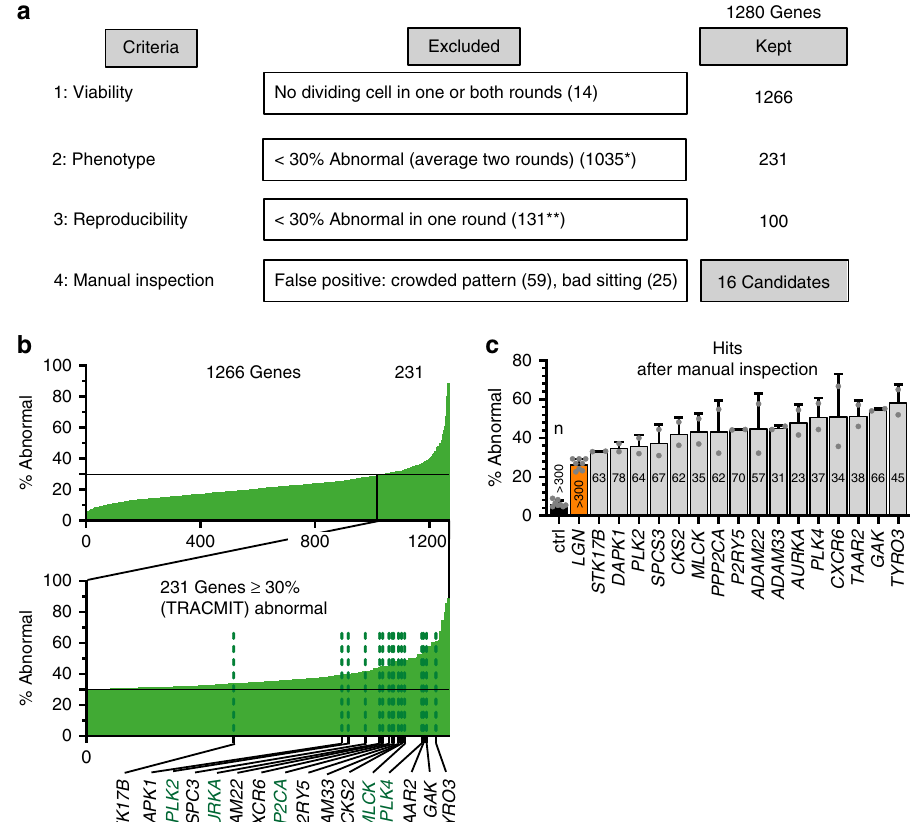
Fig. 2 Identi fi cation of 16 spindle positioning candidate genes. a Schematic representation of step-wise hit selection procedure following two rounds of screening a small interfering RNA (siRNA) collection targeting 1280 kinases, phosphatases, metalloproteases, G protein-coupled receptors and associated proteins. Left column: four criteria that were evaluated successively; middle column: exclusion criteria and number of excluded genes at each step; right column: number of genes kept after each step. *Including one gene with ≤ 10 cells to analyze and one gene with only two cells to analyze in one round, and a manually con fi rmed phenotype in the other round (PPP1CB). **Including eight genes with ≤ 10 cells to analyze and two genes with >10 cells in one round, and a manually con fi rmed phenotype in the other round, but with <20 cells to analyze ( EFNB3 , PRKACG , see also Supplementary Data 1). b Graphical representation of screen outcome, with magni fi cation of the 231 candidates exhibiting a phenotype in >30% of all cells analyzed in both rounds. The 16 candidates fi nally retained are singled out. Green lettering: candidates anticipated from prior work. c Control (ctrl) siRNA, as well as siRNAs against LGN or one of the 16 candidates remaining after manual inspection of all movies corresponding to the 106 candidates obtained in step 3 of the hit selection procedure (see a ). Shown are mean values of the percentage of abnormal cells per well in the two rounds of screening combined ±SDs and the